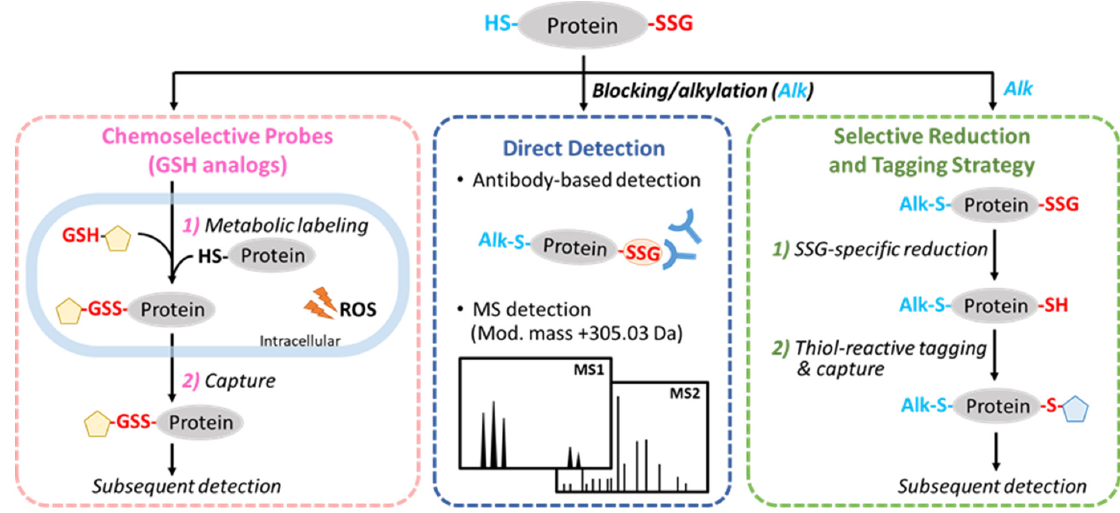
Figure 3. General strategies for detecting protein glutathionylation.